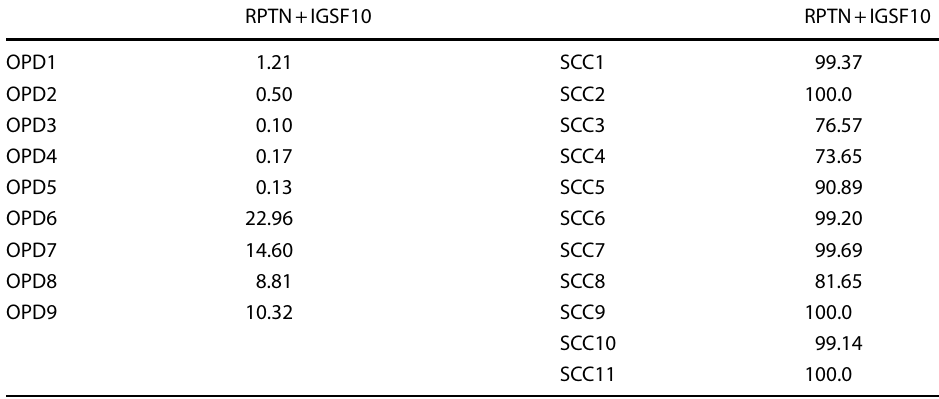
Table 1 Predicted chance (%) of SCC in our samples